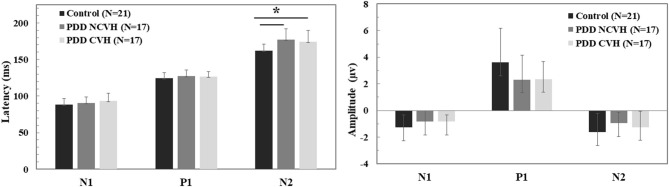
Comparison of the visual evoked potential component (N1, P1, and N2) amplitude and latency. Statistical tests: Univariate analysis of variance (ANOVA), df = 52, p–value 2 sided <0.05 significant; PDD, Parkinson's disease dementia; HC, Healthy Controls; CVH, Complex Visual Hallucination; NCVH, No Complex Visual Hallucination; *Post-hoc = CVH>HC, NCVH>HC.